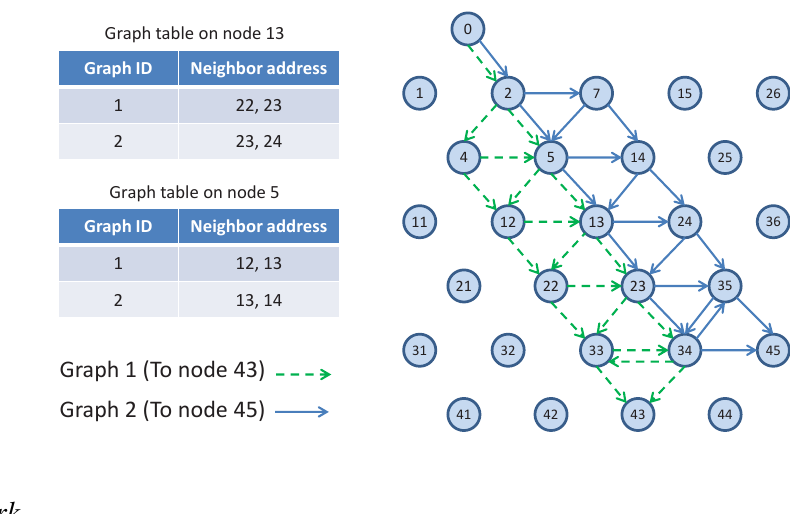
Figure 3. Graph routing sample.